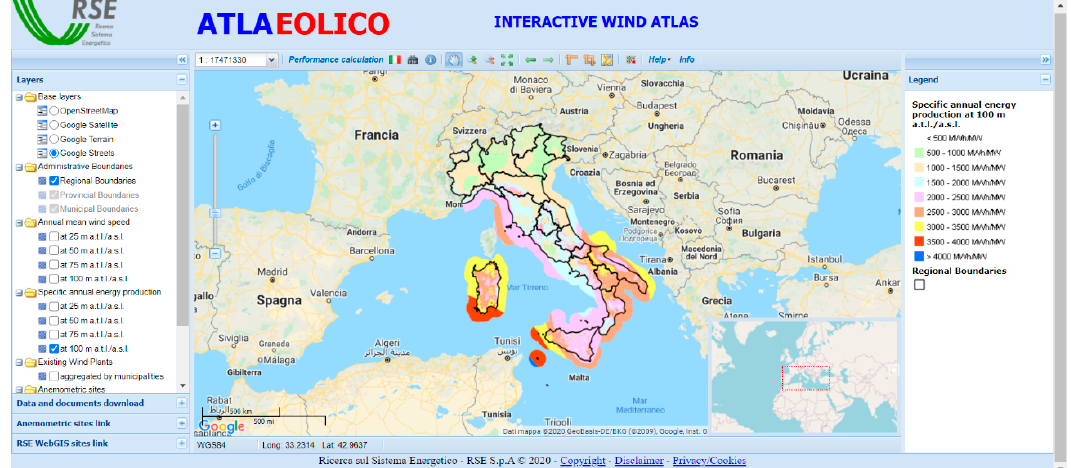
Figure 1. A view of ATLAEOLICO specific annual energy production at 100 m a.g.l./a.s.l. [21].